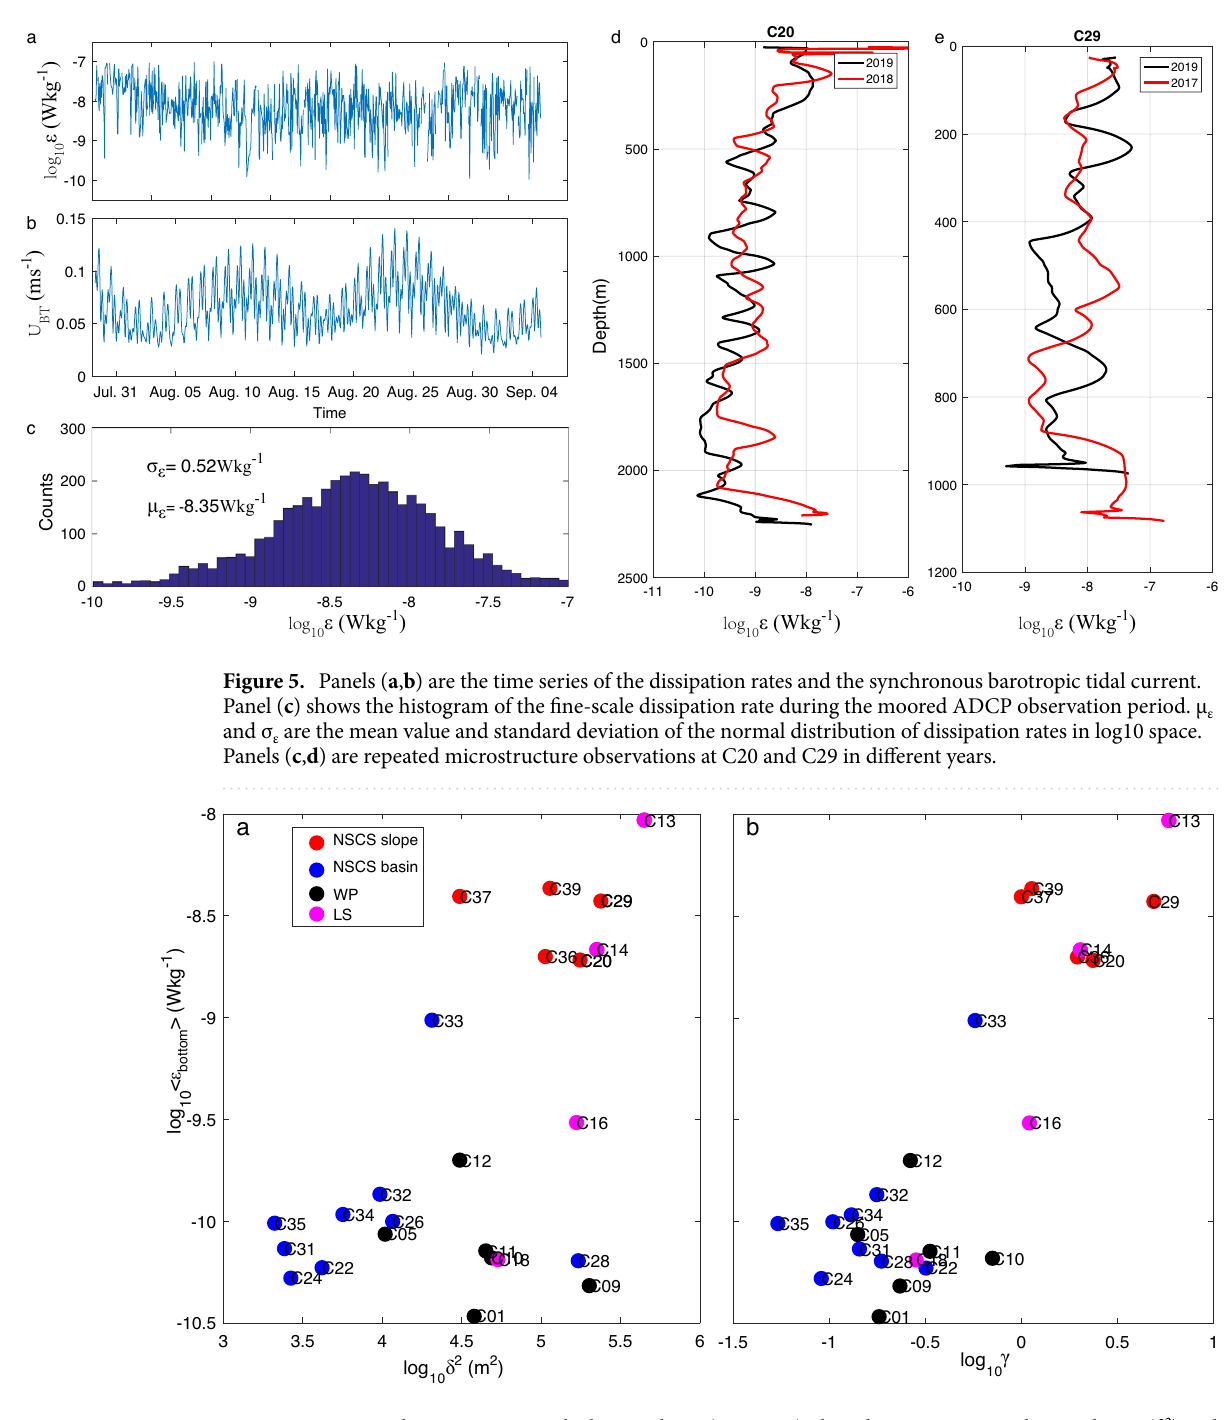
most internal tide energy is not dissipated near topographic sources and instead radiates away as low-mode internal waves 3 . In the NSCS basin, internal tides propagated in a low mode with less interaction with smooth topography, showing low dissipation 9 . The interaction between low-mode internal waves and rough topography is strongly dependent on the steepness of the topography 37 . When internal tides shoal onto the continental slope, near-critical topography ( γ ~ 1) scatters low-mode internal tides to smaller wavelengths, leading to intensified dissipation near the slope 38,39 . Thus, < ε bottom > (Fig. 6b) was highly related to slope criticality for semidiurnal tides, showing high dissipation near the slope and low dissipation in the basin.